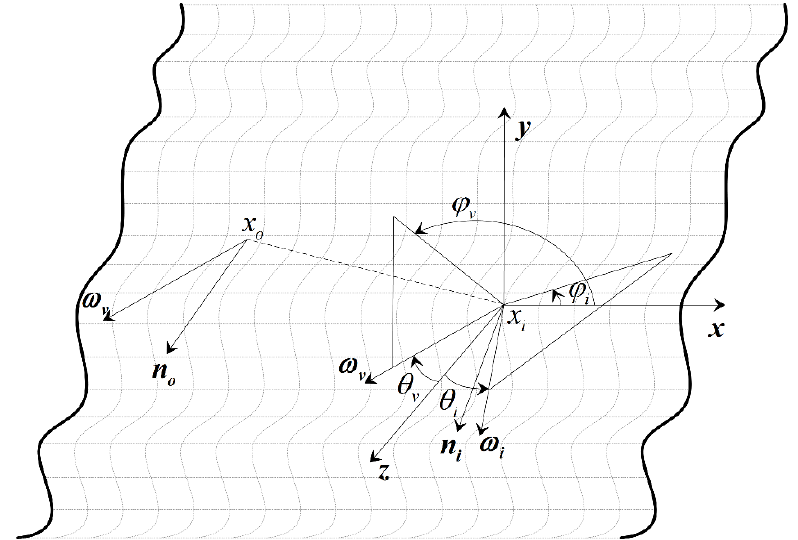
Figure 1. Geometry of light transport between incident and exitant points on the surface and the model used to calculate highlight effects.